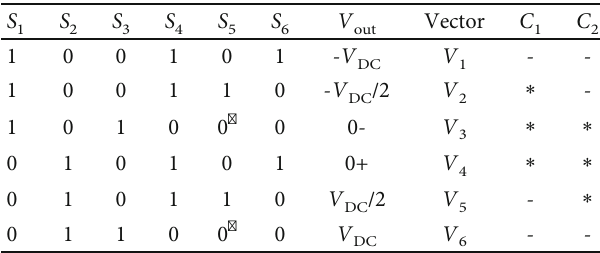
Figure 1: Proposed fi ve-level inverter drawings. Table 1: Proposed fi ve-level inverter general switching